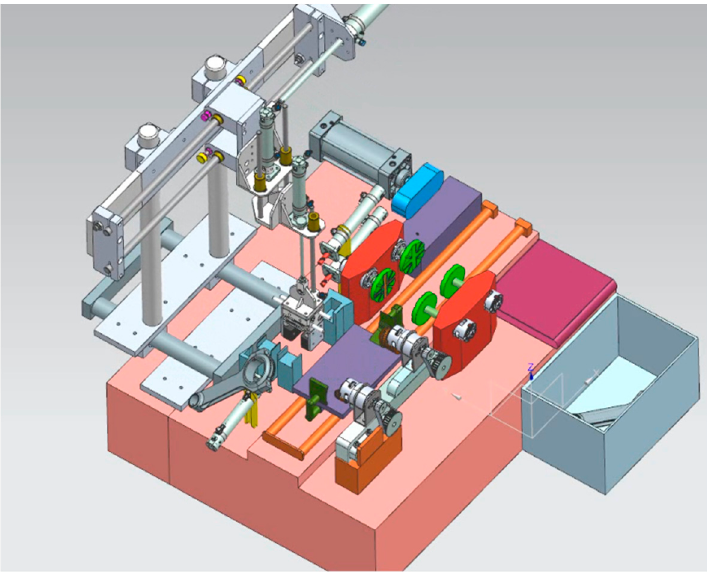
Figure 21. Connecting rod drop in debugging of the first part of the processing area.